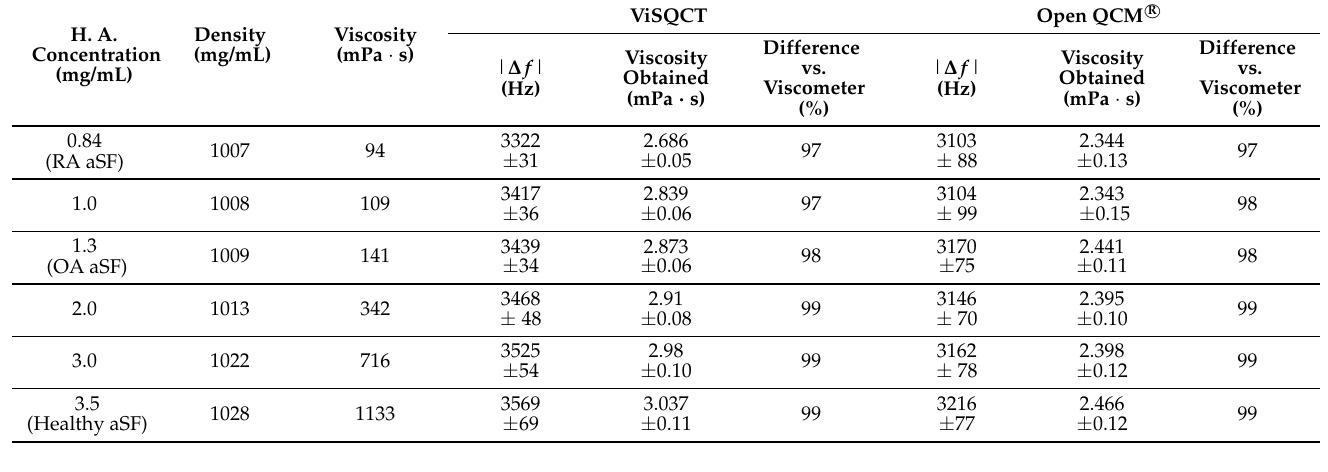
Table 5. aSF parameters and results with both sensors.